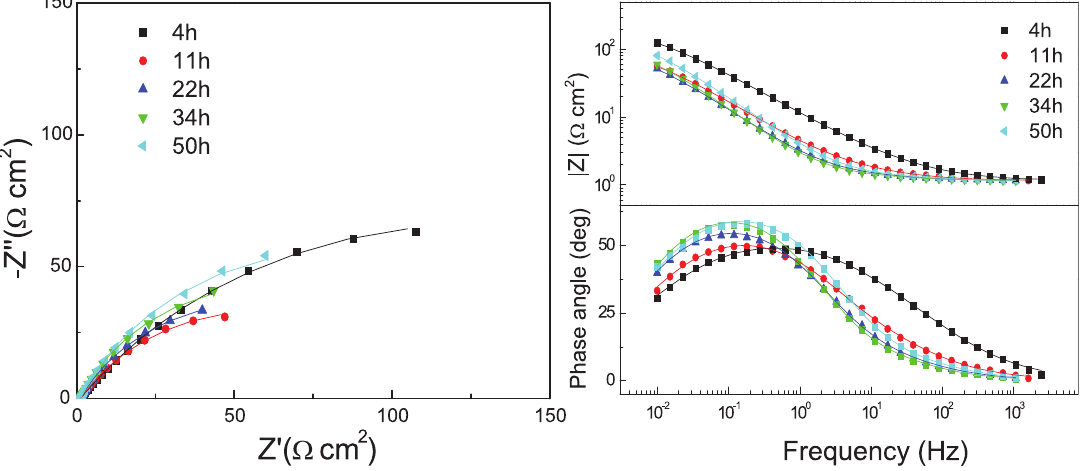
Fig. 4: Nyquist (a) and Bode (b) diagrams of pure nickel in molten (Li,Na,K)F at 973 K (Symbol: experimental data; Line: fitted data)